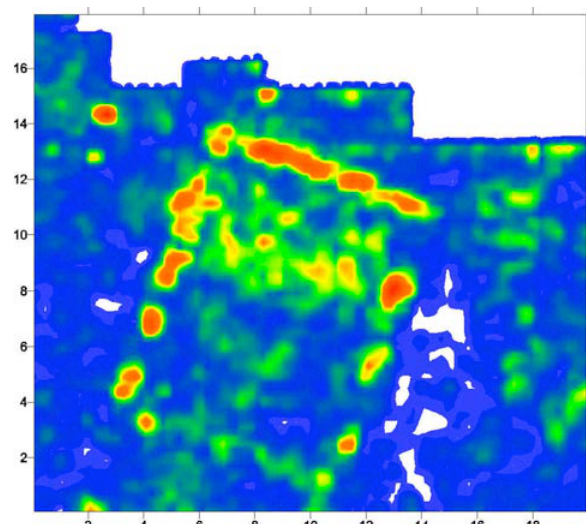
Figure 8. Old buried water tower at a depth of 2 ½ feet, south east slope. Units were chosen in this case according to the historical 16 th century distance units.